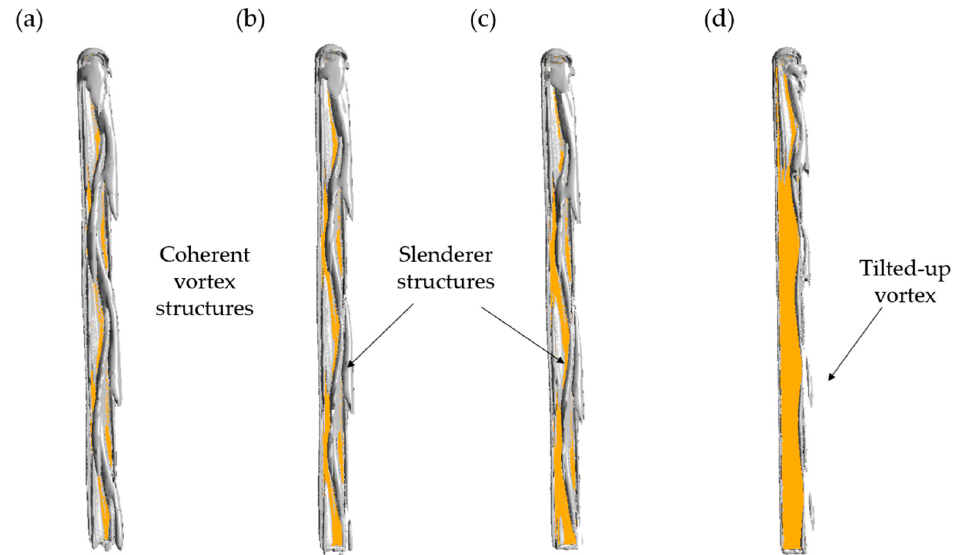
Figure 7. Three-dimensional vortex structure under different C L constraints: ( a ) C L > 0.8, ( b ) C L > 0.7, ( c ) C L > 0.6, ( d ) C L > 0.5. The iso-surfaces are outlined by dimensionless λ 2 = − 0.7. The ski is labeled by the yellow region.